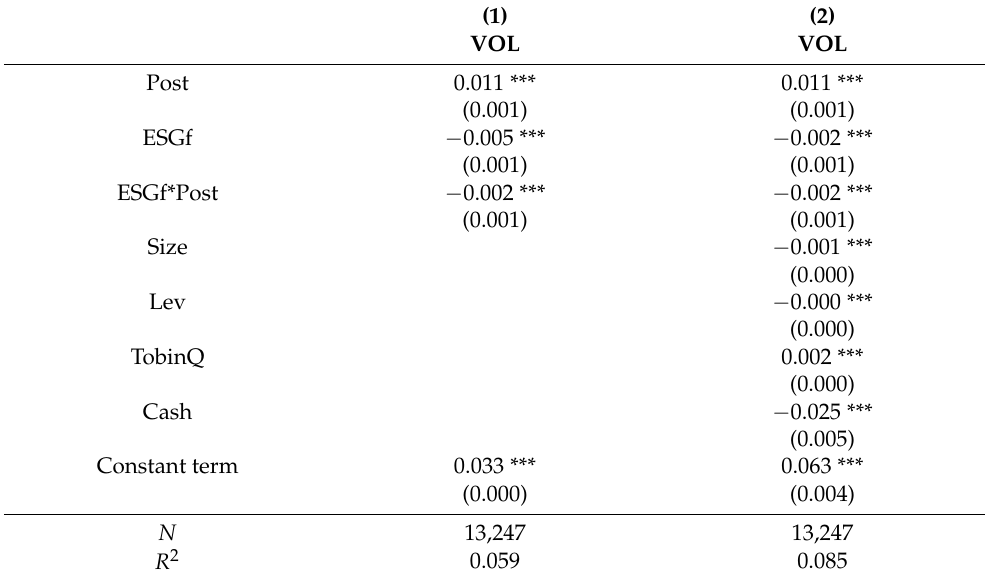
Figure 1. Intra-day volatility trend of the experimental and control groups before and after COVID- Figure 1. Intra-dayvolatilitytrendoftheexperimentalandcontrolgroupsbeforeandafterCOVID-19outbreak. 19 outbreak. Table 5. Regression results of ESG’s effect on corporate volatility before and after